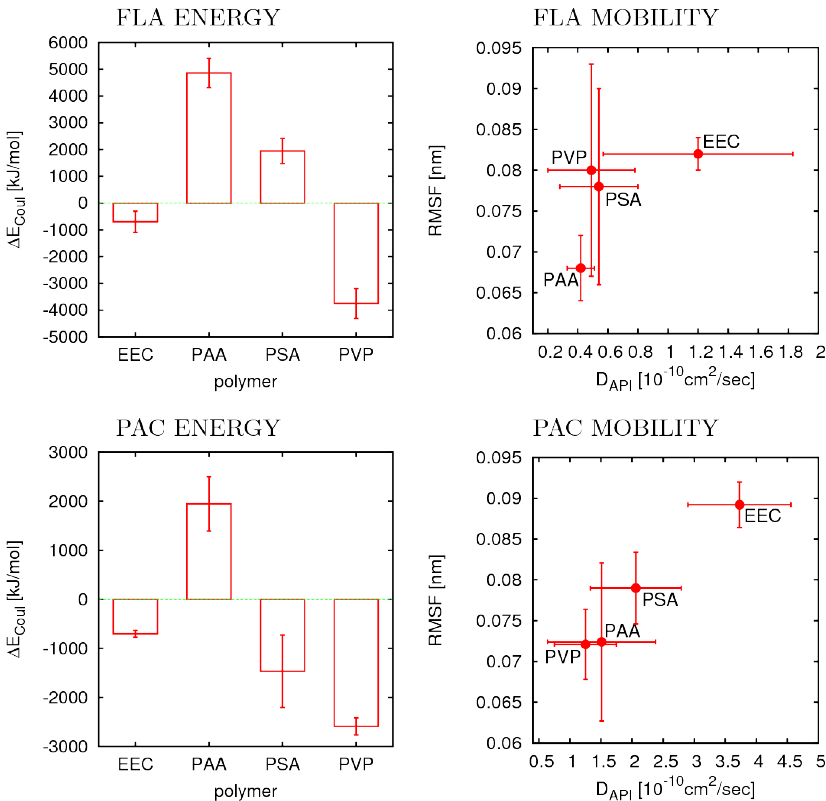
Figure 5. Results from MD simulations of API (40 wt %) blends in four different polymer matrices: FLA ( top ); and PAC ( bottom ). The two diagrams on the left show the changes of the Coulomb interaction energies upon mixing. The diagrams on the right show API translational diffusion coefficient and roto-vibrational mobility (RMSF). Each point is labeled with the corresponding polymer type. The error bars are standard deviations calculated from four